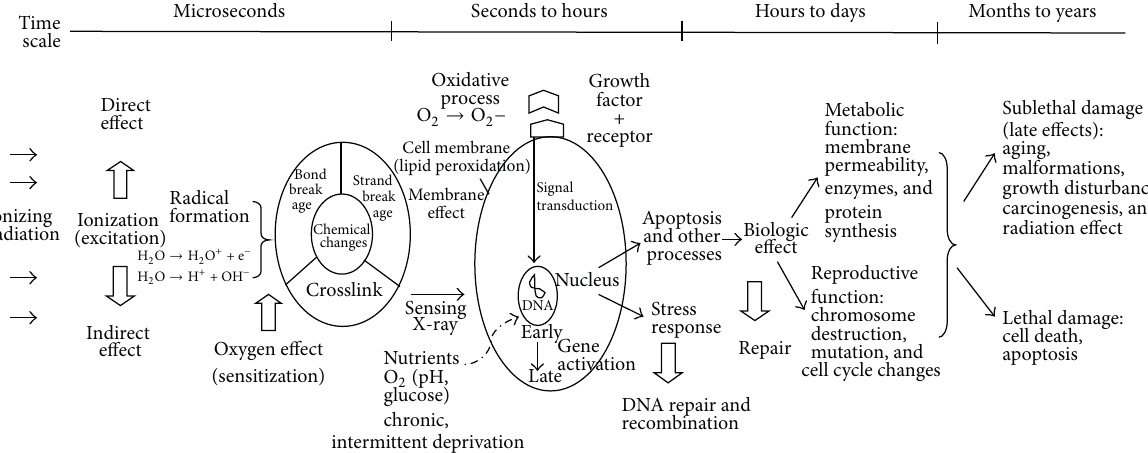
Figure 1: Fate of irradiated cell. Schematic representation of the various processes that take place after cell irradiation [14–16].